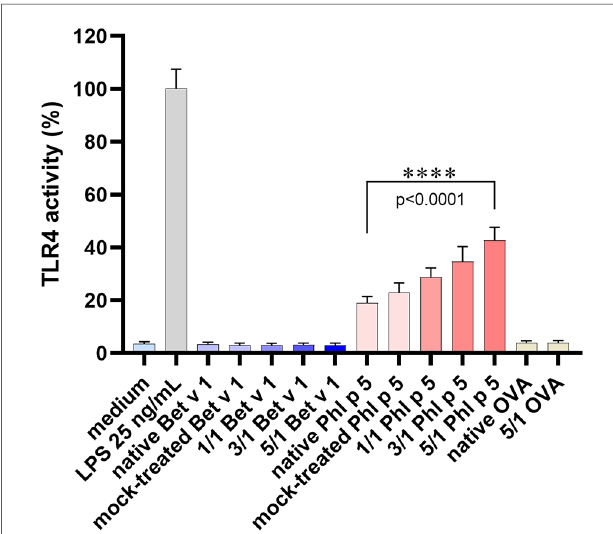
FIGURE 1 TLR4 activation of native and ONOO – -modi fi ed allergens. TLR4 activity in HeLa TLR4 dual-luciferase reporter cells determined for Betv1, Phlp5, and OVA after modi fi cation with different molar ratios of ONOO – over tyrosine (1/1, 3/1, 5/1) and 7h of incubation, normalized to LPS. Arithmetic mean values and standard deviations of two independent experiments performed in triplicates.